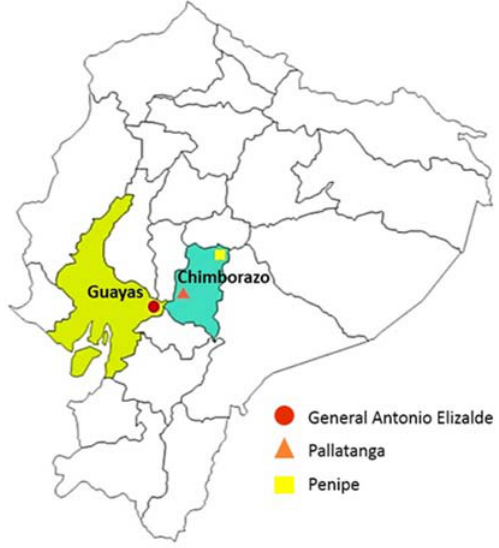
Figure 1. Map of Ecuador showing localization of the three municipalities in the Chimborazo and Guayas provinces.